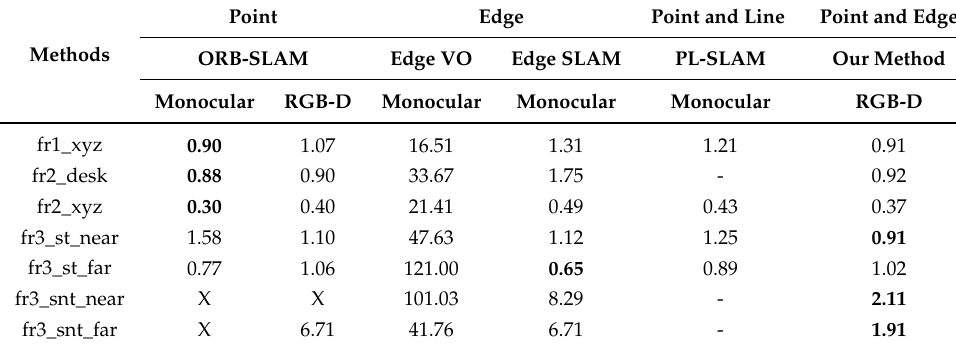
Table 1. Accuracy of camera tracking (ATE RMSE in centimeters) compared to different tracking methods on the TUMRGB-D dataset (with an Intel Core i7-4790 CPU). Bold shows the best results. X denotes uninitialized or the tracking lost.